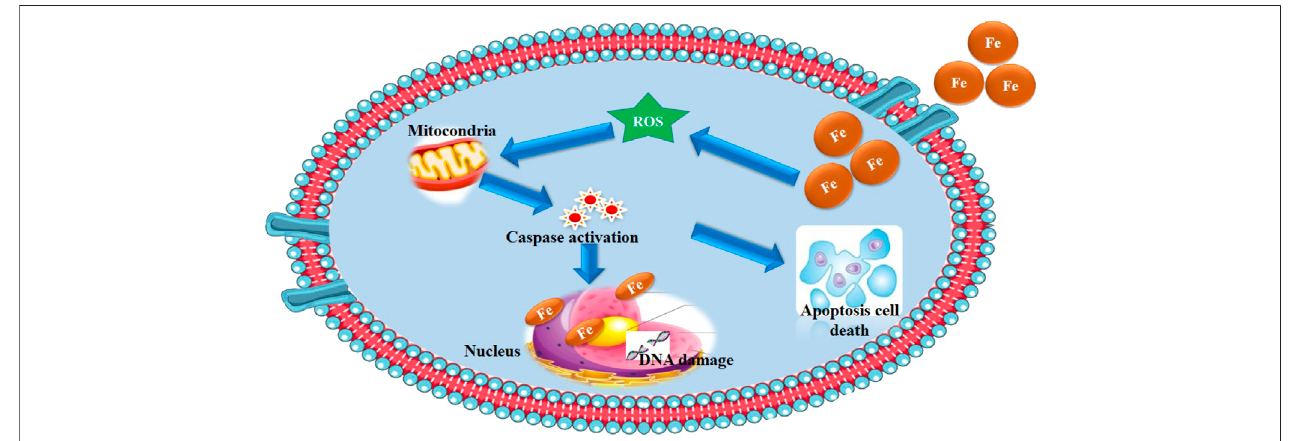
FIGURE 2 | Schematic representation of the mechanism for the cytotoxicity activity of Fe NPs.